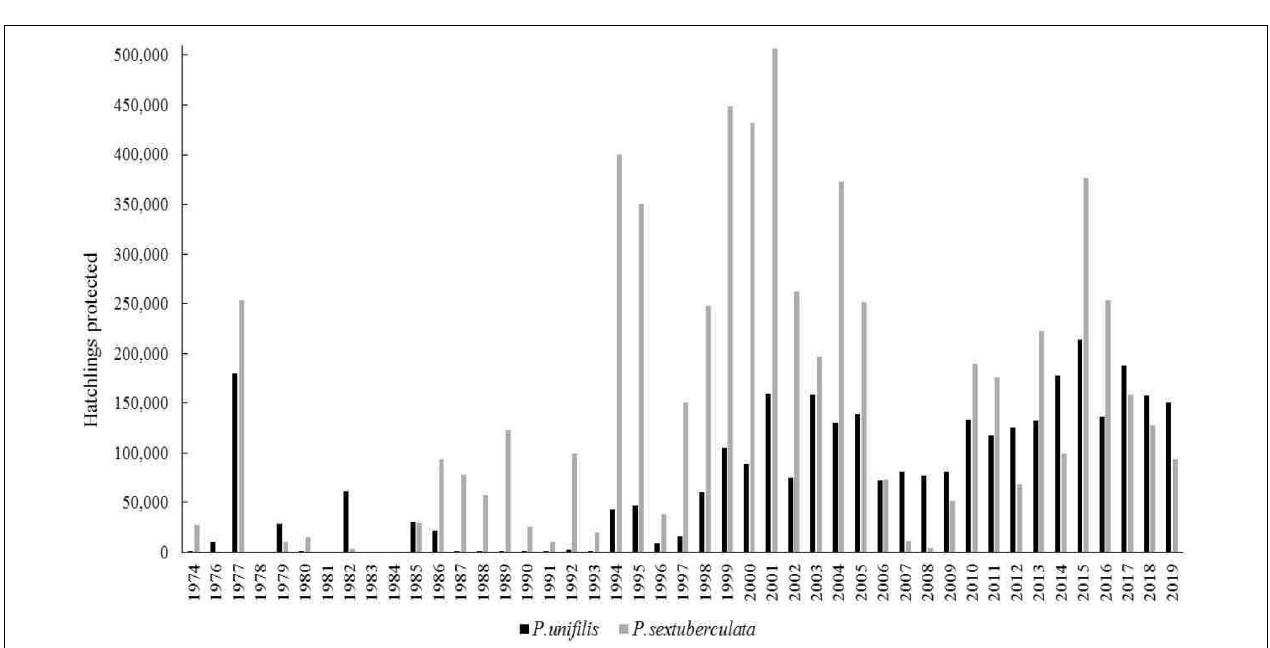
FIGURE 2 | Nests of Giant South American turtle ( P. expansa ) protected in the Amazonas state and the northwestern section of the Pará state, Brazil, between 1974 and 2019. Source: PQA/IBDF/IBAMA CPPQA and Pé-de-pincha program technical reports.